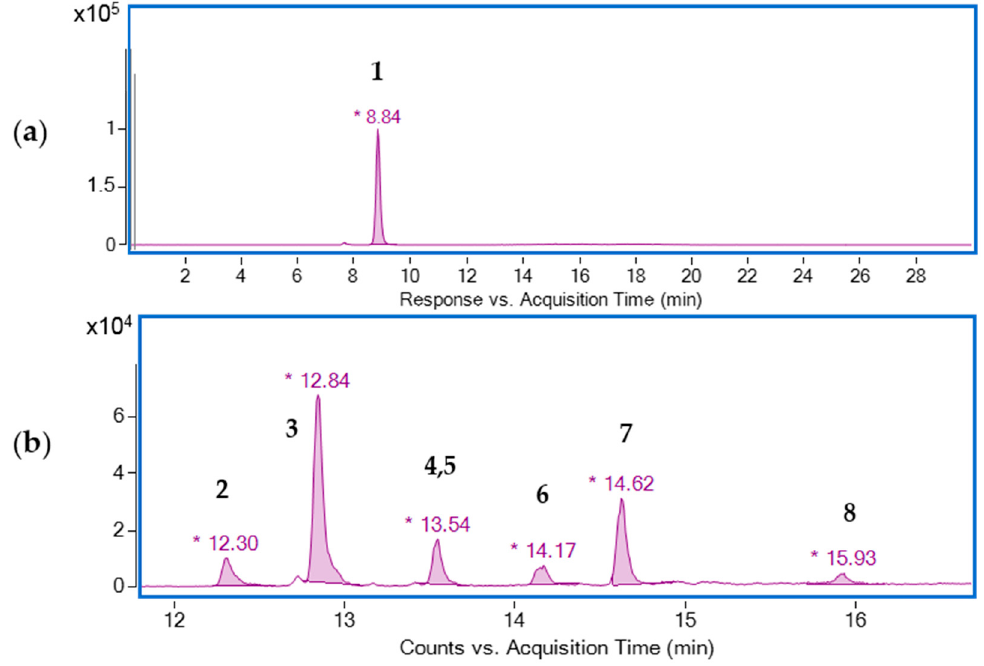
Figure 5 . Extracted ion chromatograms of ( a ) picrocrocin, ( b ) crocins, in negative ( − ESI) mode. Peak numbers correspond to compounds of Table 2. * retention time . Table 2. Compounds identified by LC-Q-TOF/MS in picrocrocin and crocin solutions obtained from SPE.